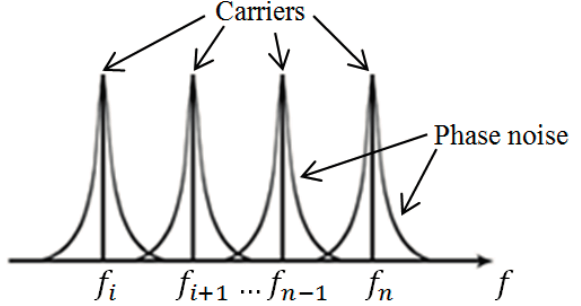
Figure 1. OFDM signal of multiple carriers, each carrier frequency has been distorted by the phase